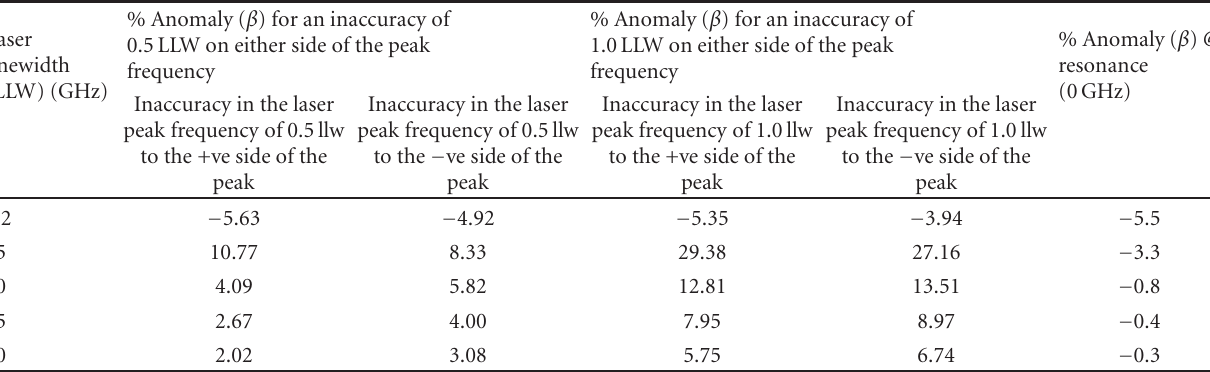
Table 3: A table of theoretically computed percentage anomalies for an inaccuracy of 0.5 δ L and 1.0 δ L for the various laser linewidths ( δ L ). Laser